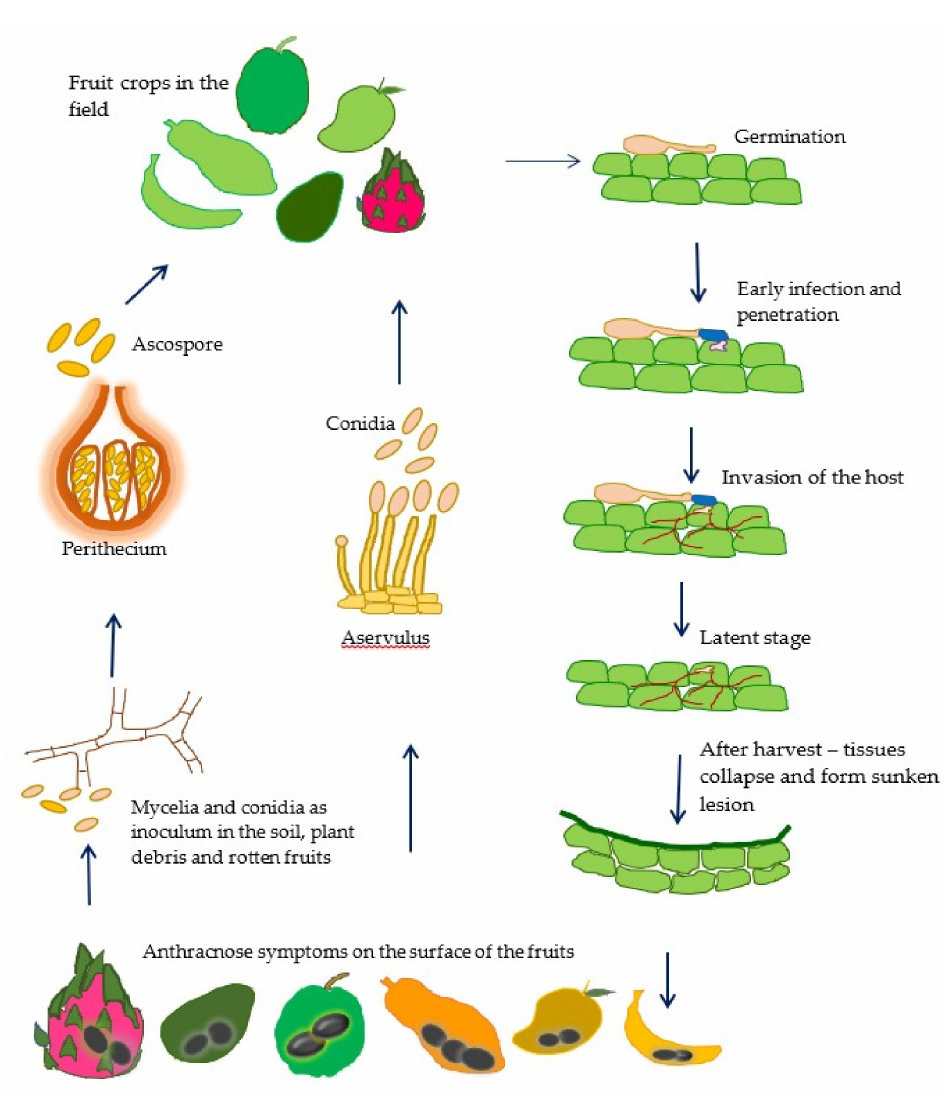
Figure 1. Anthracnose disease cycle of tropical fruit crops. (Drawn by Latiffah Zakaria). Anthracnose pathogens infect not only fruits, but also other plant organs, including the leaves, flowers, twigs, and branches. The conidia and spores formed in these infected tissues are subsequently released and dispersed during rainy days through water splashes or during high humidity periods, thus becoming the primary inoculum for fruit infection at the preharvest stage [11]. The most visible anthracnose symptoms are black or dark brown sunken lesions containing conidial masses on the surface of infected fruits [7]. Small individual lesions may merge to produce larger lesions. These black or dark brown lesions on the surface appear unattractive to consumers and significantly reduce the market value of such fruits. Figure 2A–E show the anthracnose lesions form on the surface of several tropical fruit